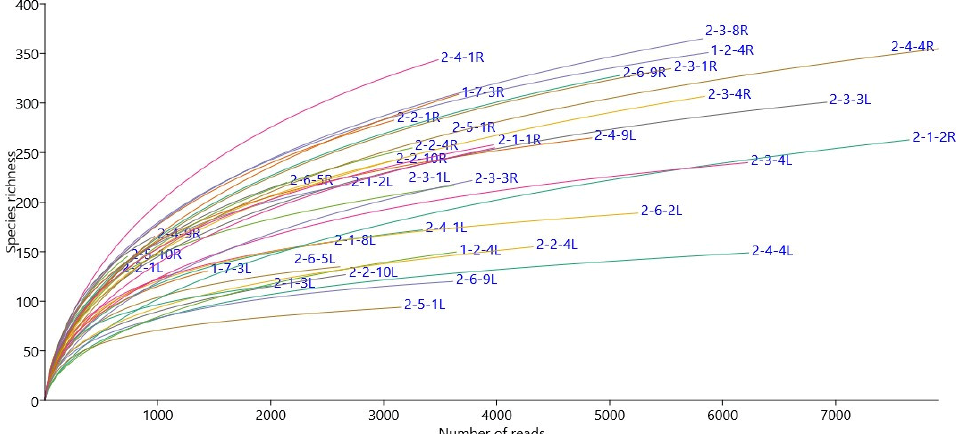
Figure 5. Rarefaction curves for each sample for endophytic bacterial community data in meadow fescue ( Festuca pratensis ) showing species richness to the number of reads acquired. Each curve is marked with the sample name and specific tissue (L: leaf, R: root).